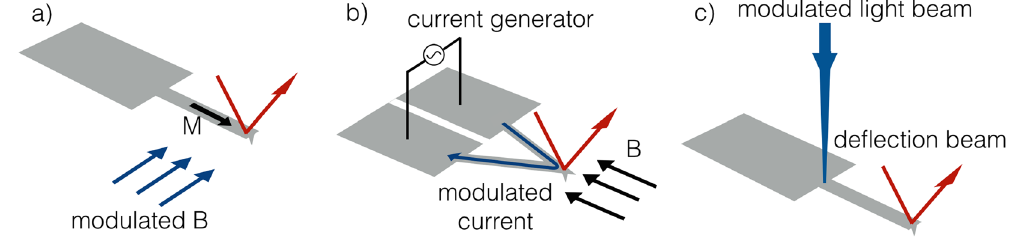
Figure 9. Excitation methods for the